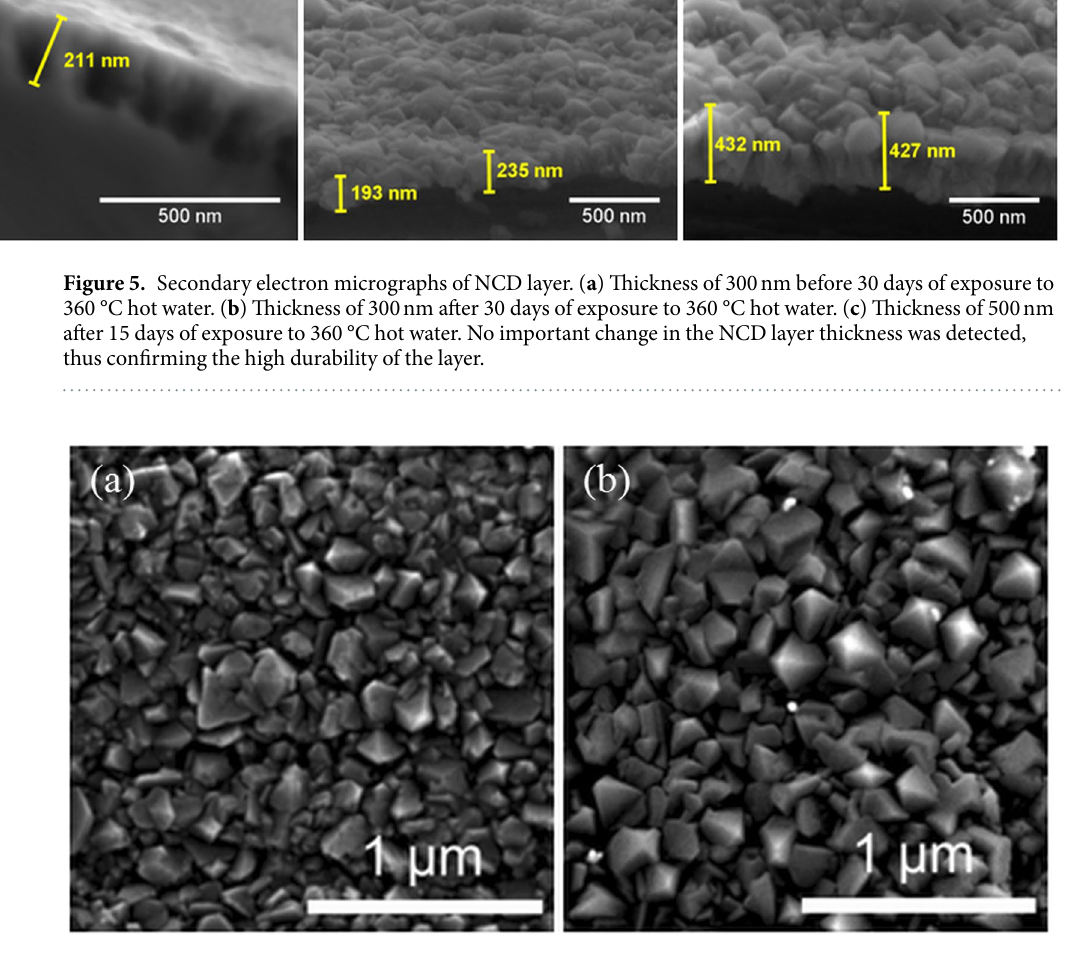
Figure 6. Secondary electron micrographs of the initial surface of a Zr alloy sample covered with 300 nm thick NCD (left) and the surface after 30 days of exposure to 360 °C hot water (right). No microstructural changes were observed in the hot-water-processed NCD